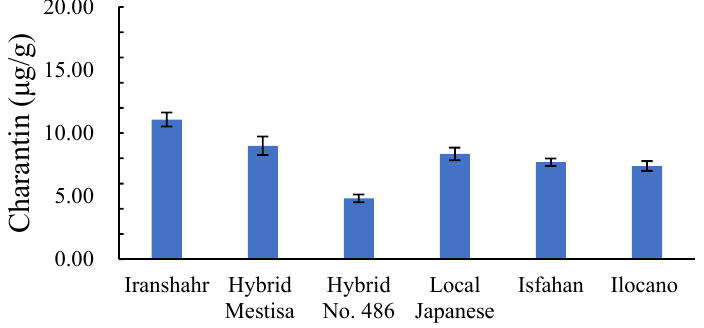
Figure 4. Leaf charantin content in six bitter melon cultivars grown under Karaj conditions.